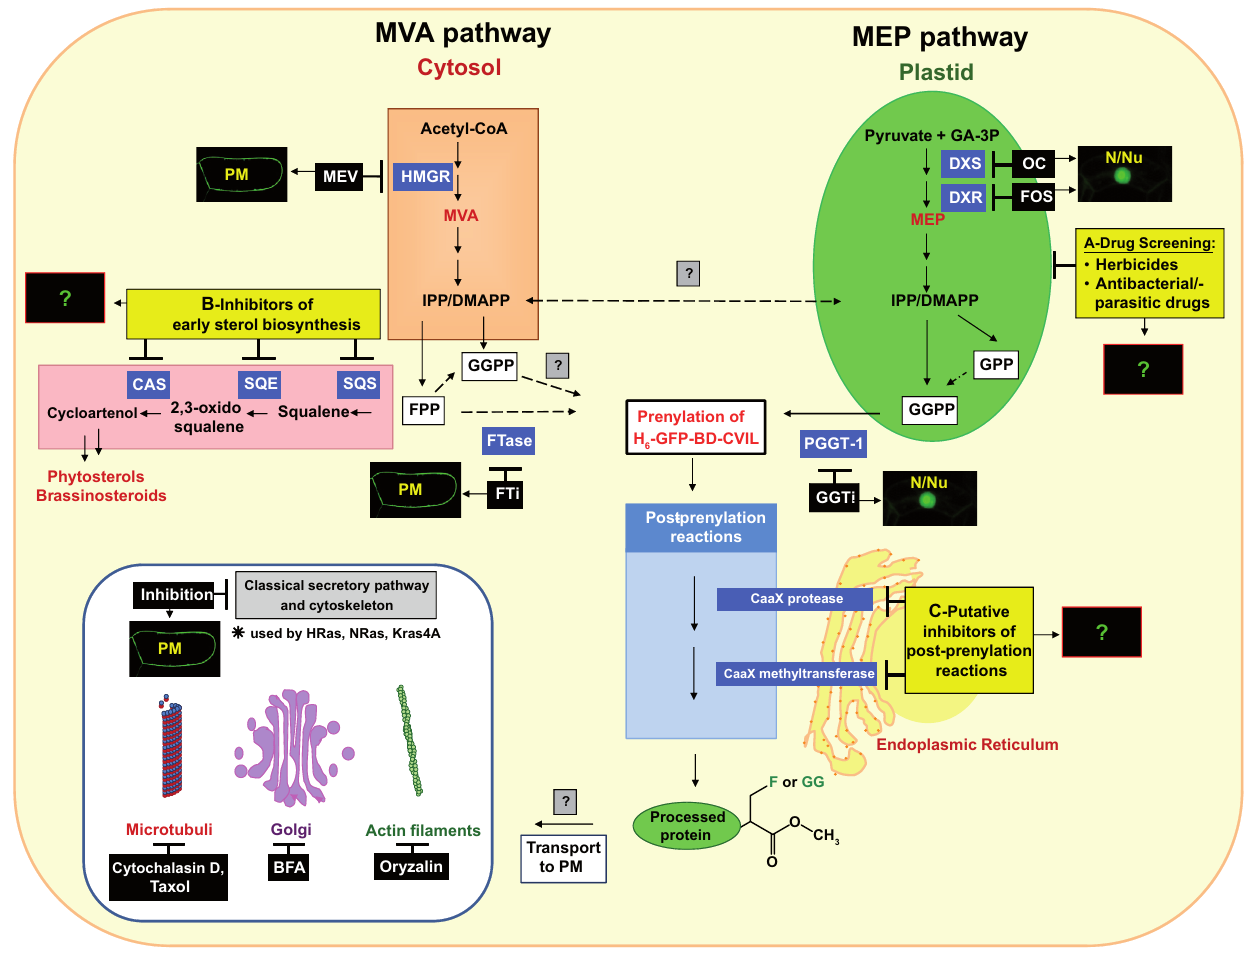
Figure S3. Overview of the treatments in the context of previous results obtained with a test system based on the fluorescent reporter protein H -GFP-BD-CVIL in transgenic tobacco BY-2 cells. In previous studies, the following phenotypes were observed after 6 treatments of the transgenic H -GFP-DB-CVIL cell line with inhibitors of both isoprenoid biosynthetic pathways: Inhibition of the cytosolic MVA 6 pathway by mevinolin (MEV) a specific inhibitor of HMG-CoA reductase (HMGR) did not exhibit any detectable effect on the intracellular localization of the prenylable GFP fusion protein which predominantly associated with the plasma membrane (PM), as observed under control conditions. Specific inhibition of DXS and DXR, key enzymes in the plastidial MEP pathway by oxoclomazone (OC) and fosmidomycin (Fos), respectively, however lead to a dramatic mislocalization of the GFP fluorescence (compare main text for more detailed information) to the nuclear compartment (N/Nu). A similar effect was observed with compounds that interfere with protein geranylgeranyltransferase type I (PGGT-1). This differential localization of the GFP fusion protein in response to inhibitors of the two coexisting routes leading to the synthesis of the universal C5 precursors IPP (and its isomer DMAPP) in plants indicates the suitability of this system for screening of compounds with potential antimicrobial and herbicidal activities. In the present study this potential for drug screening will be addressed by testing novel compounds, specifically designed to inhibit DXS and DXR enzyme activity, thereby validating the test system (yellow box A). In addition,